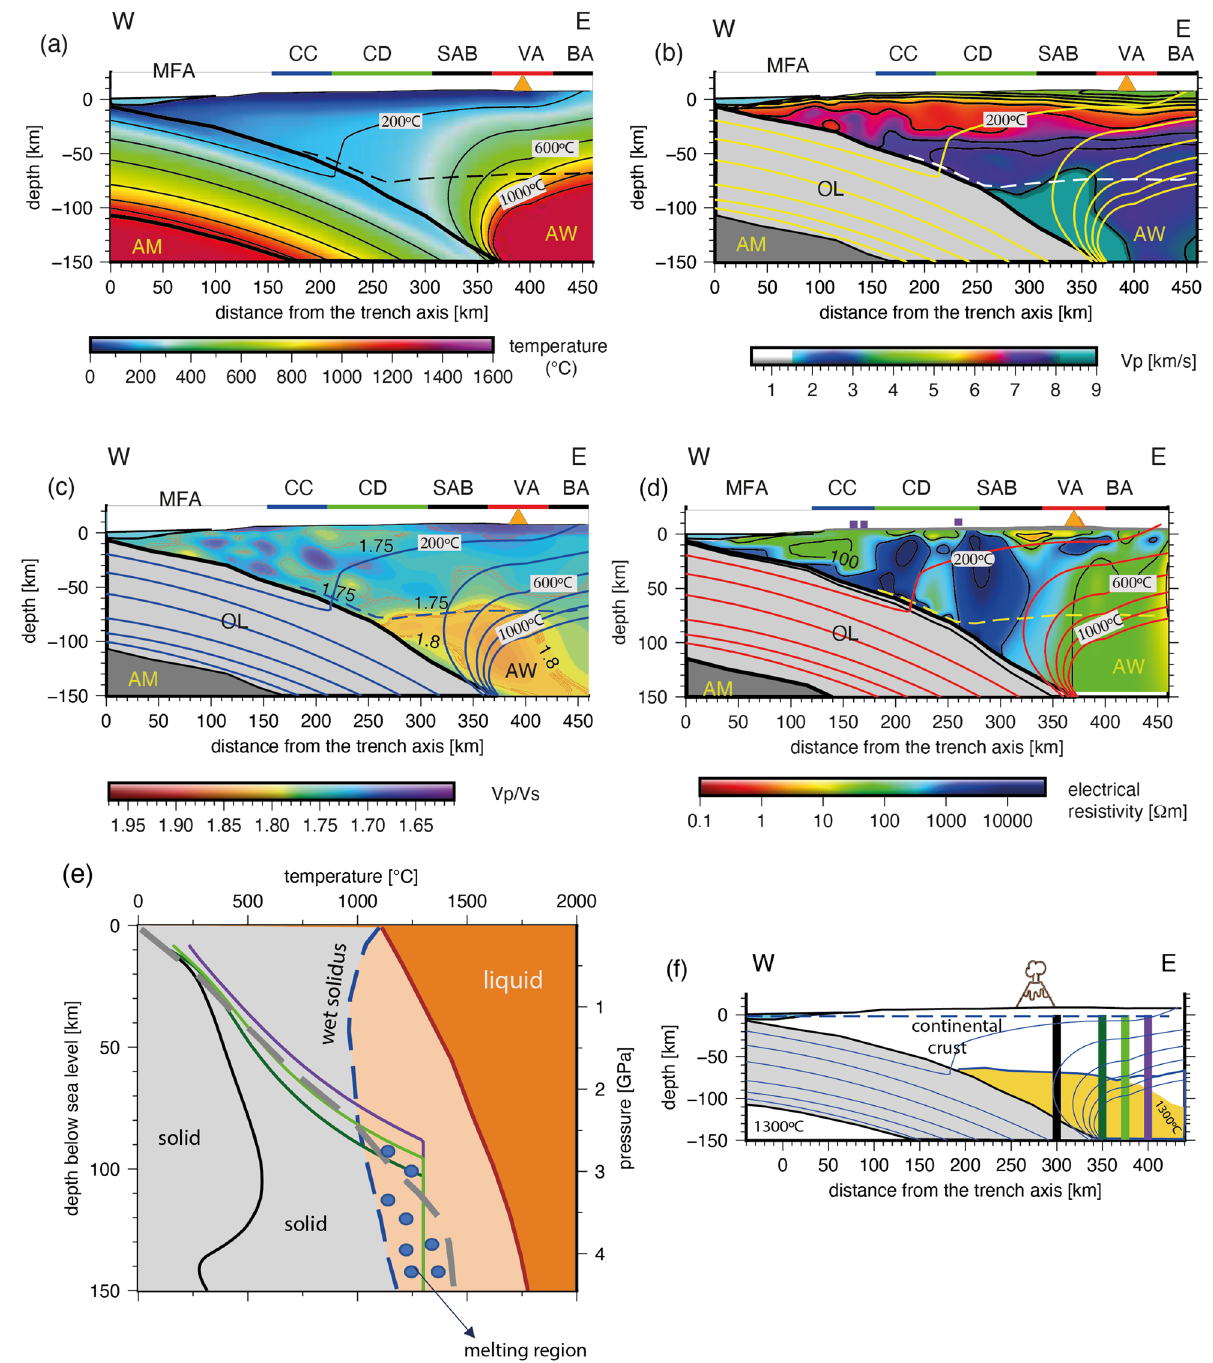
Figure 4. Trench perpendicular geophysical cross section along P03 (23.5°S). ( a ) 2-D thermal model for northern Chile from Cabrera et al. 3 . MF: Marine Forearc, CC: Coastal Cordillera, CD: Central Depression, SAB: Salar de Atacama Basin, VA: Volcanic Arc, BA: Back Arc (Puna), OL: Oceanic Lithosphere, AM; Asthenospheric Mantle, and AW: Asthenospheric Wedge (defined by temperatures higher than 1300 °C). ( b ) V p , ( c ) V p / V s ratio, and ( d ) electrical resistivity models. Isotherms are based on the thermal model shown in ( a ). Orange triangle indicates the location of the main active volcano (Lascar and Miñiques). ( e ) Geotherms extracted from the 2-D thermal model shown in ( a ) across x =300 (black curve), 350 (dark green curve), 375 (green light curve), and 400 (purple curve) km long-profile as is shown in ( f ). The dashed grey curve corresponds to the average mantle rock geotherm beneath a volcanic arc in subduction zones 8 . The presence of water reduces the solidus temperature (wet-solidus curve) allowing partial melting generation at lower temperatures and lower confining pressures. These physical conditions are reached beneath the volcanic- ≥ 90 km depth) and back-arcs ( ≥ 70 km depth). We use the GMT version 5.0 (https:// www. gener ic- mappi ng- tools. org) and Inskape version 0.97 (https:// www. inska pe. org/) softwares for generating the